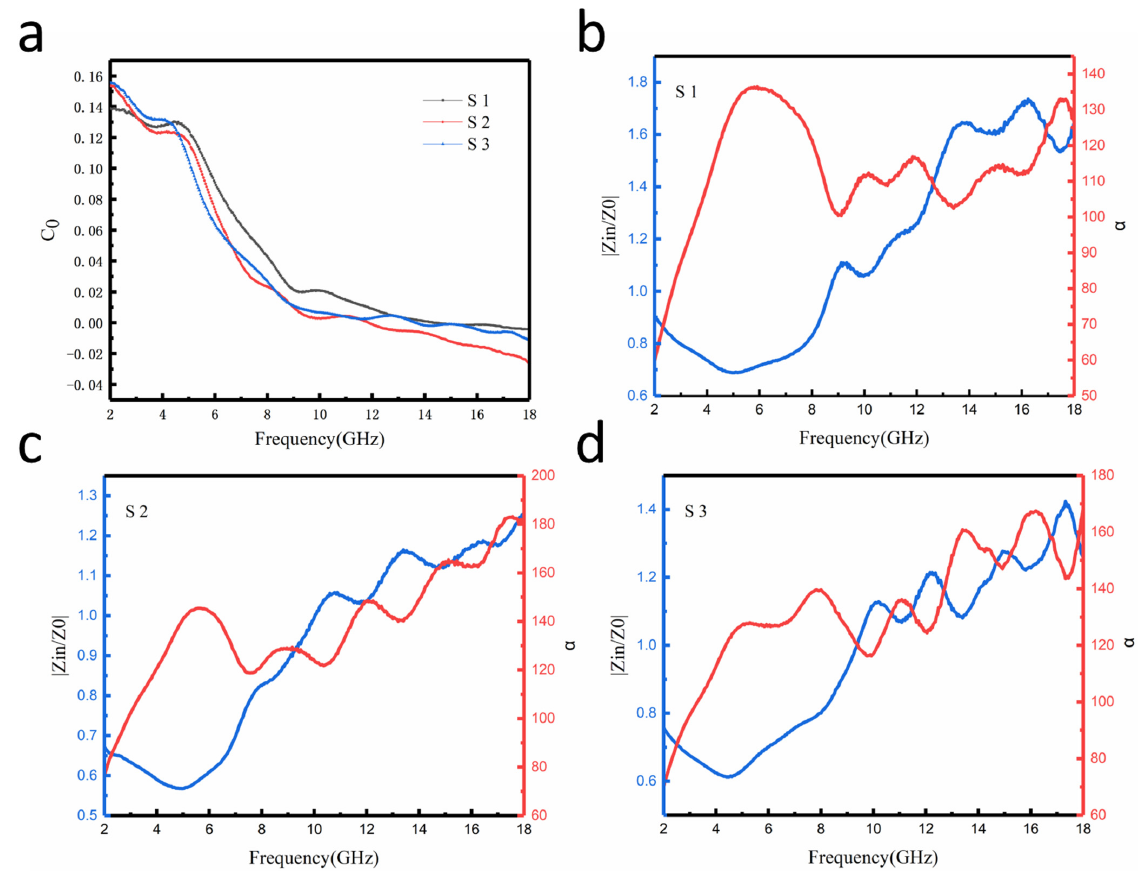
Figure 8. ( a ) Eddy current curve of the Fe 3 O 4 @rGO composites. Impedance matching and loss curves of ( b ) S1, ( c ) S2, and ( d ) S3 for a thickness of 1.75 mm.